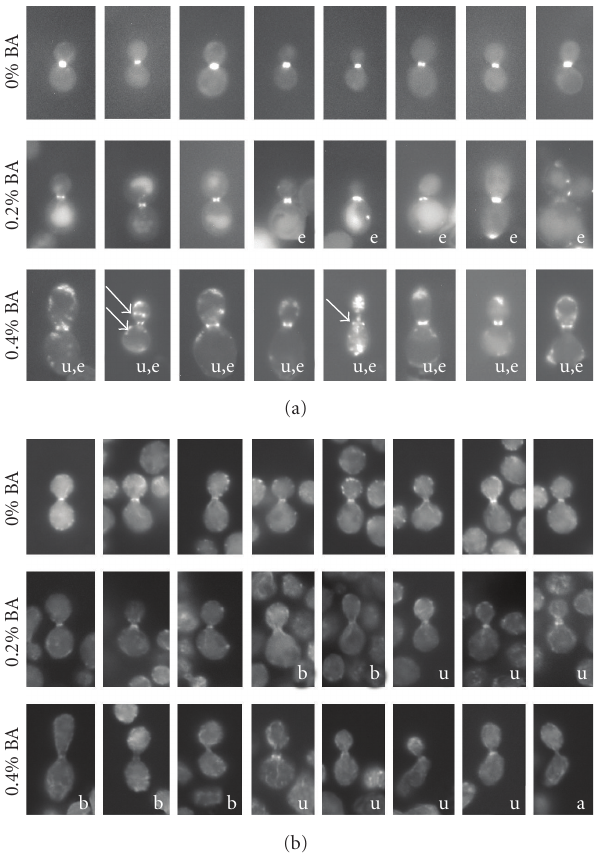
Figure 4: Appearance of the actomyosin rings in BA-treated cells. (a) Localization of Myo1GFP. Increasing concentrations of BA leads to irregular localization of Myo1GFP. Images show samples of normal, uneven rings not centered at the bud neck (u) and ectopic localization (e) of Myo1GFP patches. Note that at 0.4% BA Myo1GFP forms rings at locations other than the bud site that appear as bands in the selected images (arrows). (b) Localization of actin. The selection of images shows that increasing concentrations of BA causes actin rings to appear blurred (b) and uneven/not centered at the bud neck